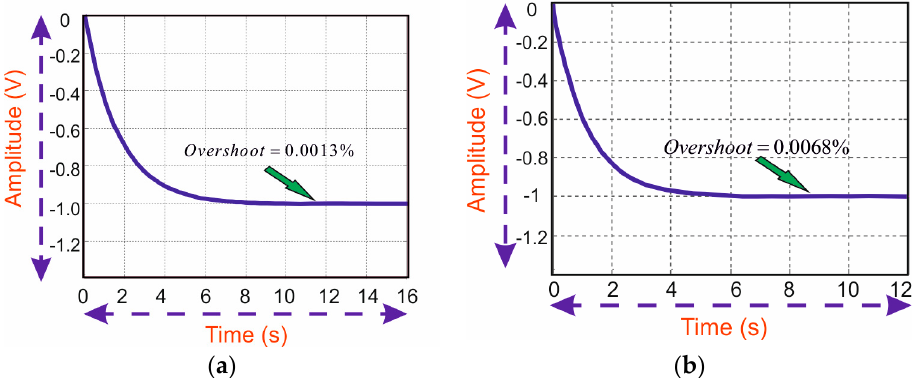
Figure 12. Step response of the system in closed loop ( a ) with V 1 source and ( b ) with V 2 source.